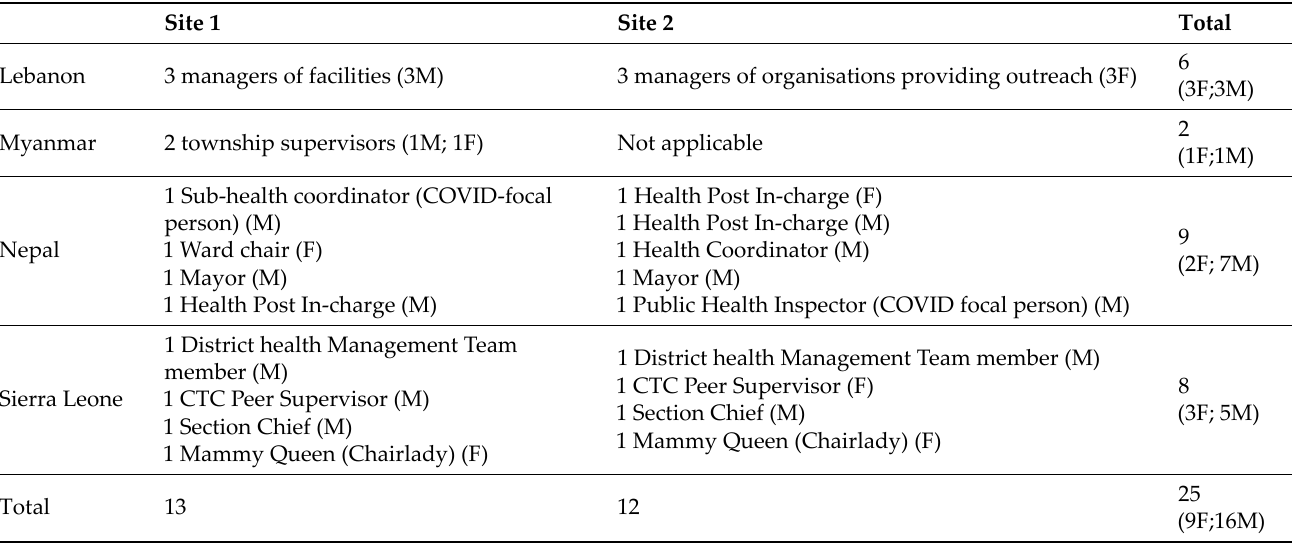
Table 1. Details of the key informants.